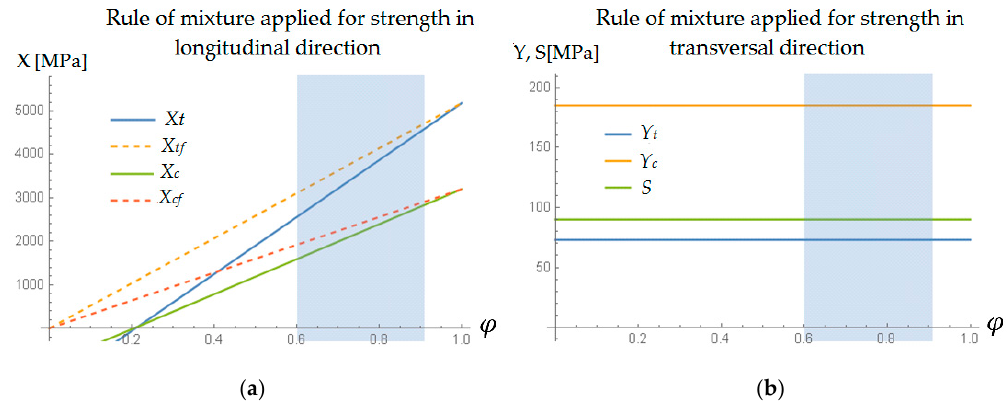
Figure 8 . Approximation of consequent strengths due to varying volume fractions in: ( a ) longitudinal and ( b ) transverse to fiber and shear directions.